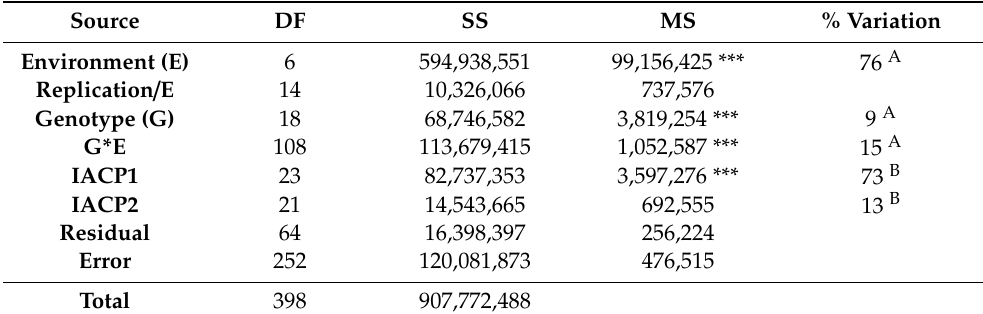
Analysis of variance for yield (kg ha − 1 ) of 19 accessions of grass pea in 7 environments (DF: degrees of freedom; SS: sum of squares; MS: mean square; G*E: term of the genotype-by-environment